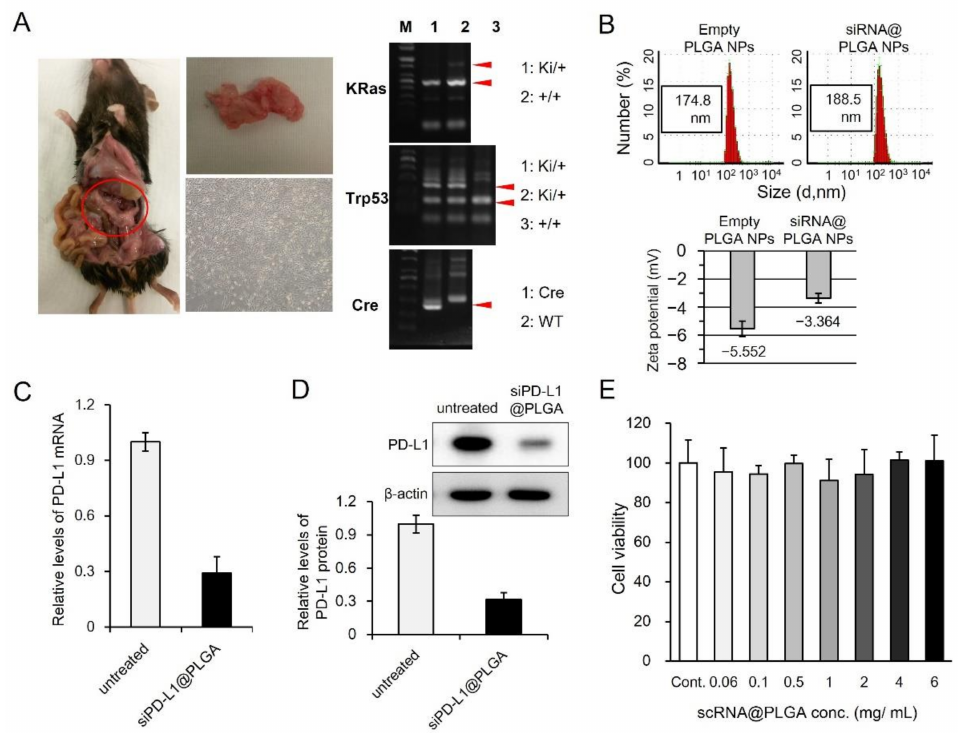
Figure 1. siPD-L1@PLGA suppresses PD-L1 expression in pancreatic cancer cells without toxicity. ( A ) (left panels) Representative photographs of a pancreatic tumor and primary cells isolated from the KRasG12D; Trp53R172H; Ptf1aCre mouse model. (Right panels) Genotyping results